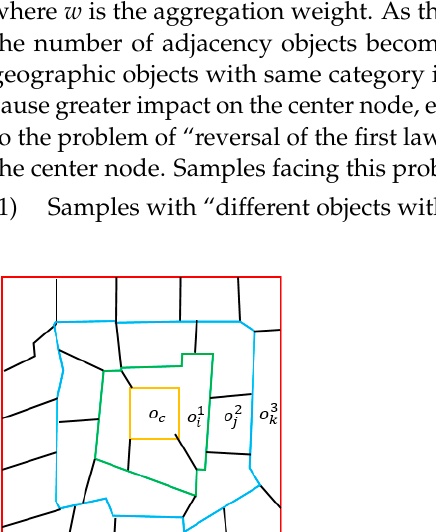
Figure 1. Demonstration of the center node and its neighbors with different spatial distances. The center node is (cid:1867) (cid:3030) . (cid:1867) (cid:3036)(cid:2869) , (cid:1867) (cid:3037)(cid:2870) and (cid:1867) (cid:3038)(cid:2871) represent the neighboring nodes with spatial distances of 1, 2, and 3, respectively.